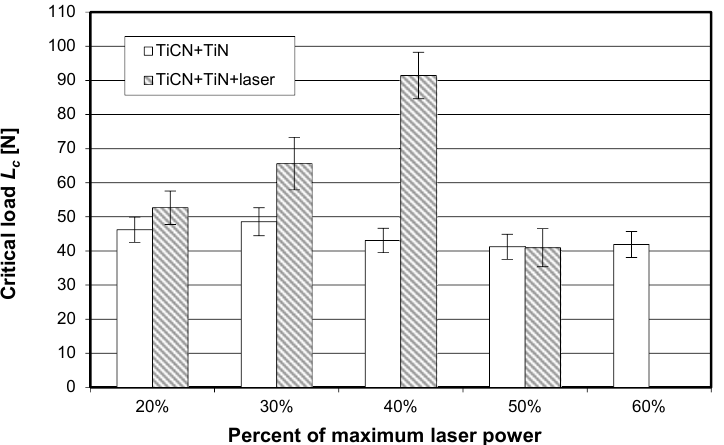
Figure 7. Impact of laser heating on the adhesion (critical load determined by scratch test) of the double-layer coating (TiCN + TiN) to the SM25 sintered carbide cutting inserts P15–P40).